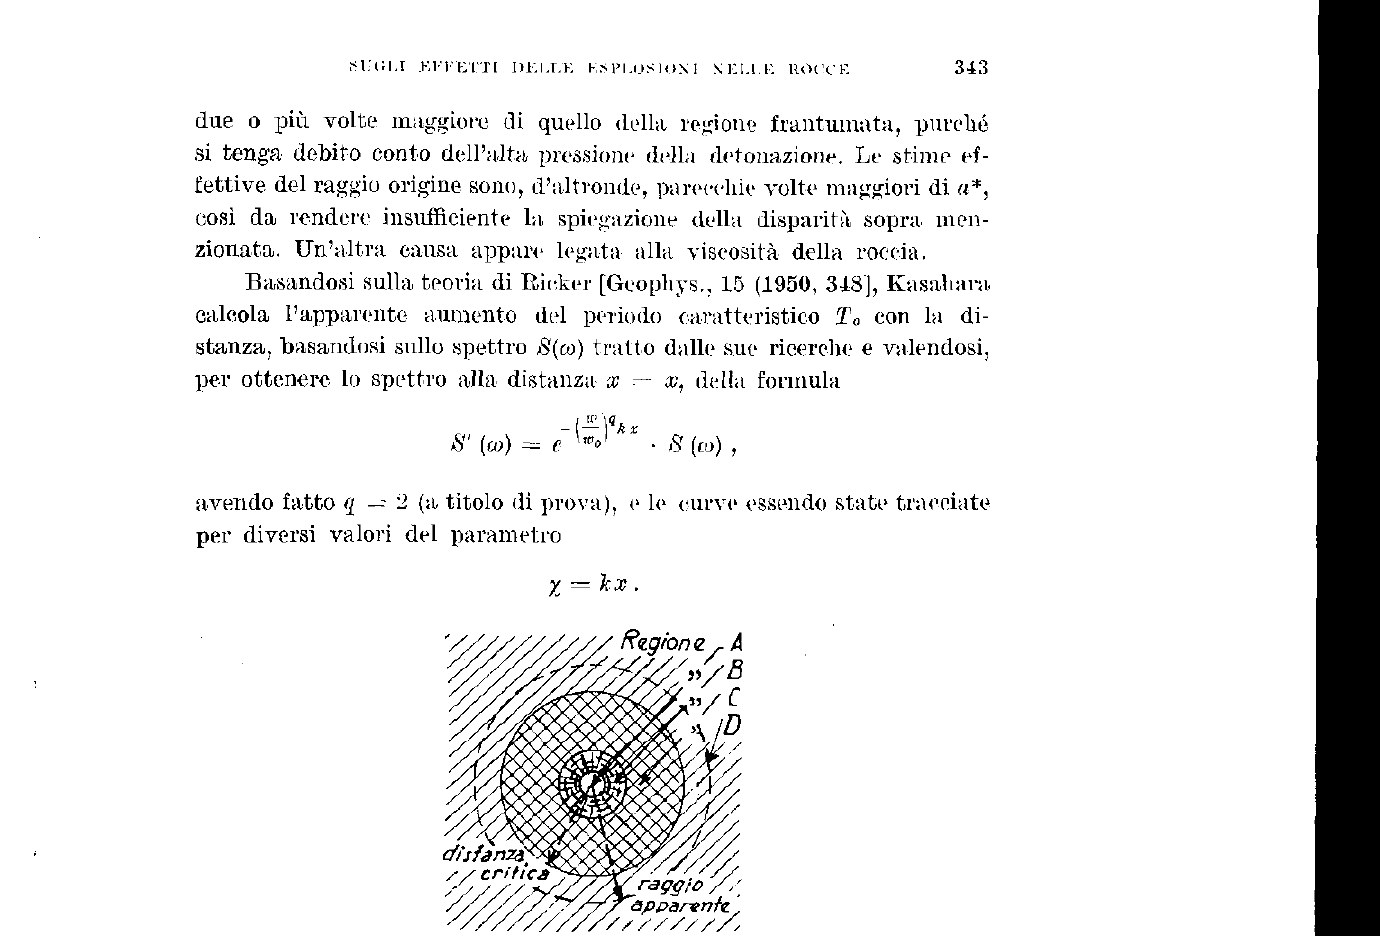
Fig. 5 - Visione schematica delle alterazioni in un mezzo solido elastico, conseguenti ad esplosioni. Regione A) cavità di scoppio; B) roccia frantu- mata; G) regione anelastica (plastica), fratturata; D) zona elastica. La linea tratteggiata limita l'apparente raggio-origine delle onde elastiche, quale risulta dai periodi